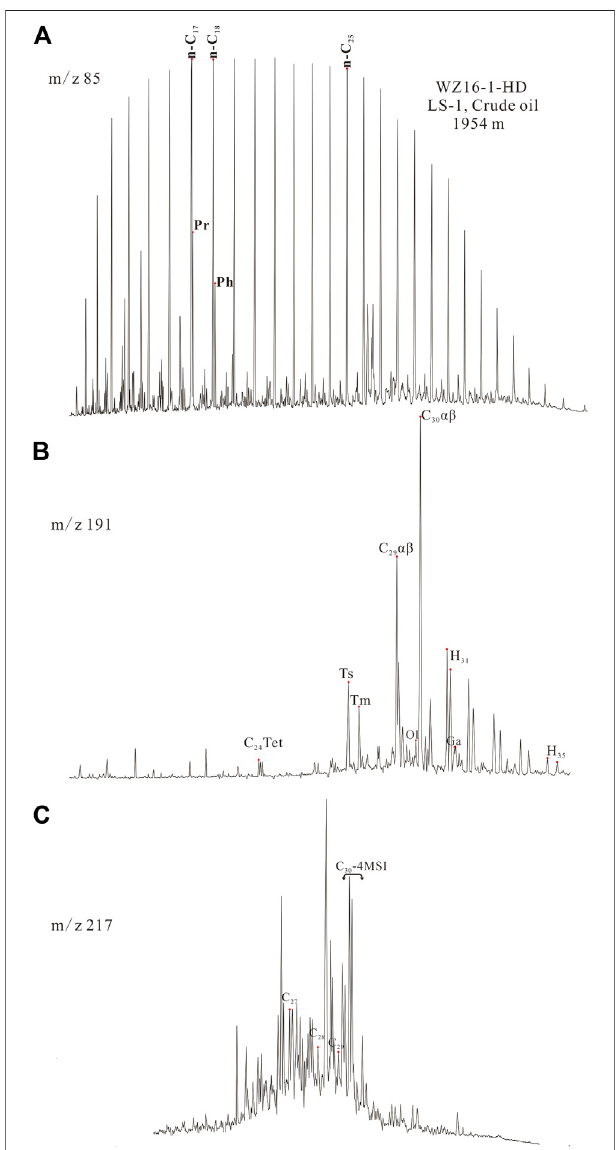
FIGURE 5 | Mass chromatograms of m/z 85 (A) , 191 (B) , and 217 (C) for the representative Wushi oil. C 27 , C 28 and C 29 = C 27 , C 28 and C 29 ααα 20R steranes; C 30 -4MSI = C 30 4-methylsteranes; LS-1 = fi rst member of the Liushagang Formation; LS-2 = second member of the Liushagang Formation; LS-3 = third member of the Liushagang Formation. The symbolic meanings of other compounds can be found in Table 2 .